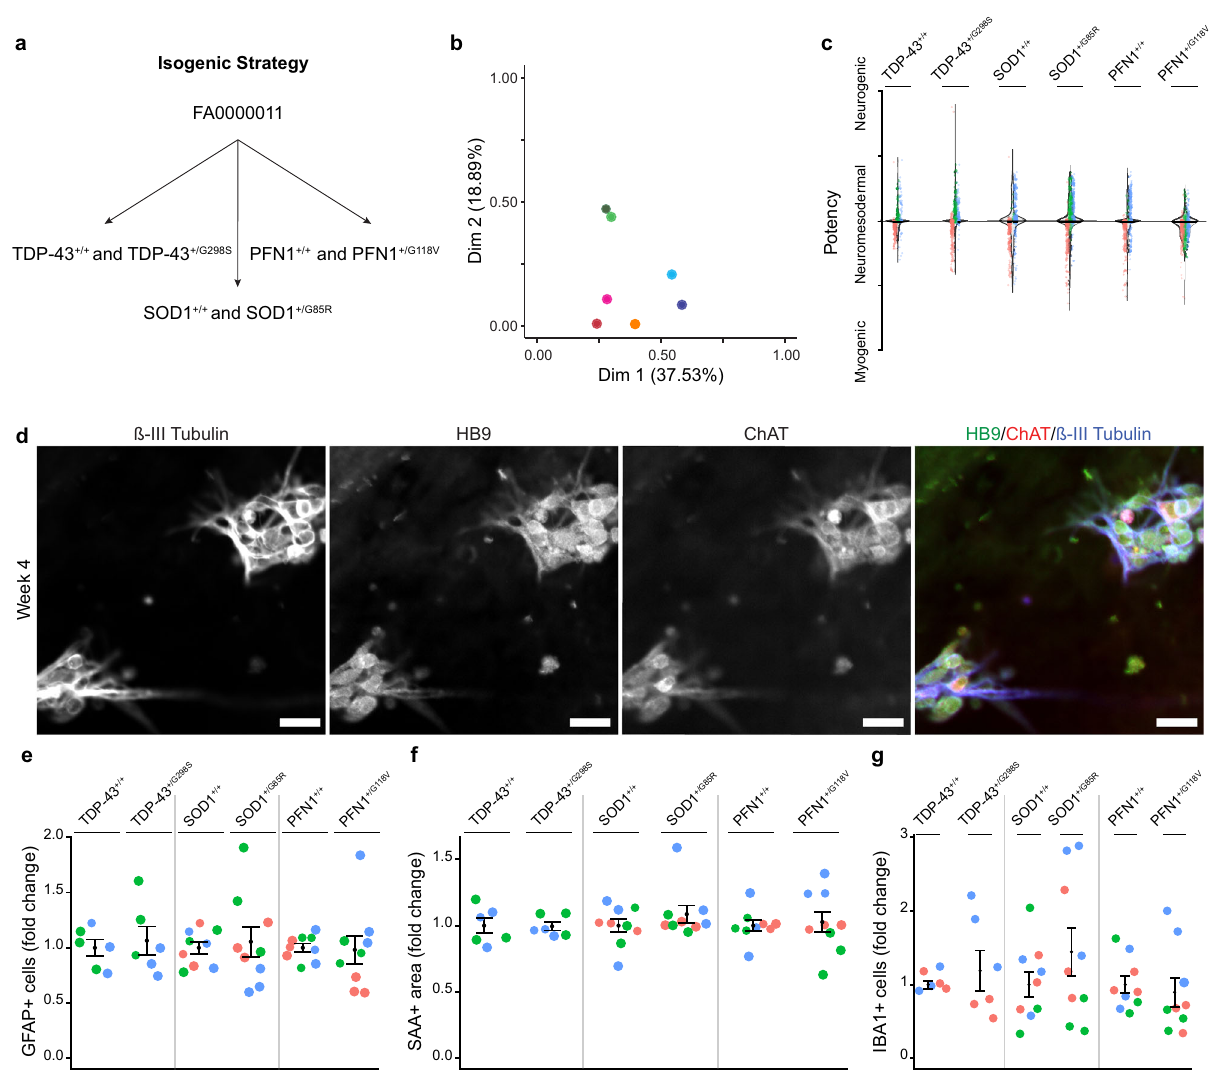
Fig. 6 Gene-edited iPSC lines are paired with their isogenic controls and generate sensorimotor organoids with similar compositions. a Strategy for CRISPR/Cas9-mediated insertion of point mutations in either TARDBP (TDP-43), SOD1 , or PFN1 into the FA0000011 control line. b Multiple correspondence analysis of TDP-43 + / + (dark green), TDP-43 + /G298S (light green), SOD1 + / + (dark blue), SOD1 + /G85R (light blue), PFN1 + / + (red), PFN1 + /G118V (pink), and the original healthy control line FA0000011 (orange). c Distribution of individual spheres according to their expression of myogenic (TBXT) or neurogenic (SOX2) transcription factors from three independent biological differentiation replicates (colors). d Spinal motor neurons expressing HB9, ChAT, and β -III Tubulin, in organoid cultures of the SOD1 + /G85R iPSC line at 4 weeks (con fi rmed in three independent biological differentiation replicates). Scale bar, 40 µ m. e – g , Quanti fi cation of GFAP + cells ( e ), SAA + area ( f ), and IBA1 + cells ( g ) in organoid cultures at 6 weeks, normalized to paired isogenic controls, per differentiation. Bars indicate mean and SEM. ( n = 6 – 9 organoid cultures obtained from 2 – 3 independent biological differentiation replicates, in distinct colors, of each of six lines; Kruskal – Wallis, P = 0.934 ( e ), P = 0.432 ( f ), P = 0.983 ( g